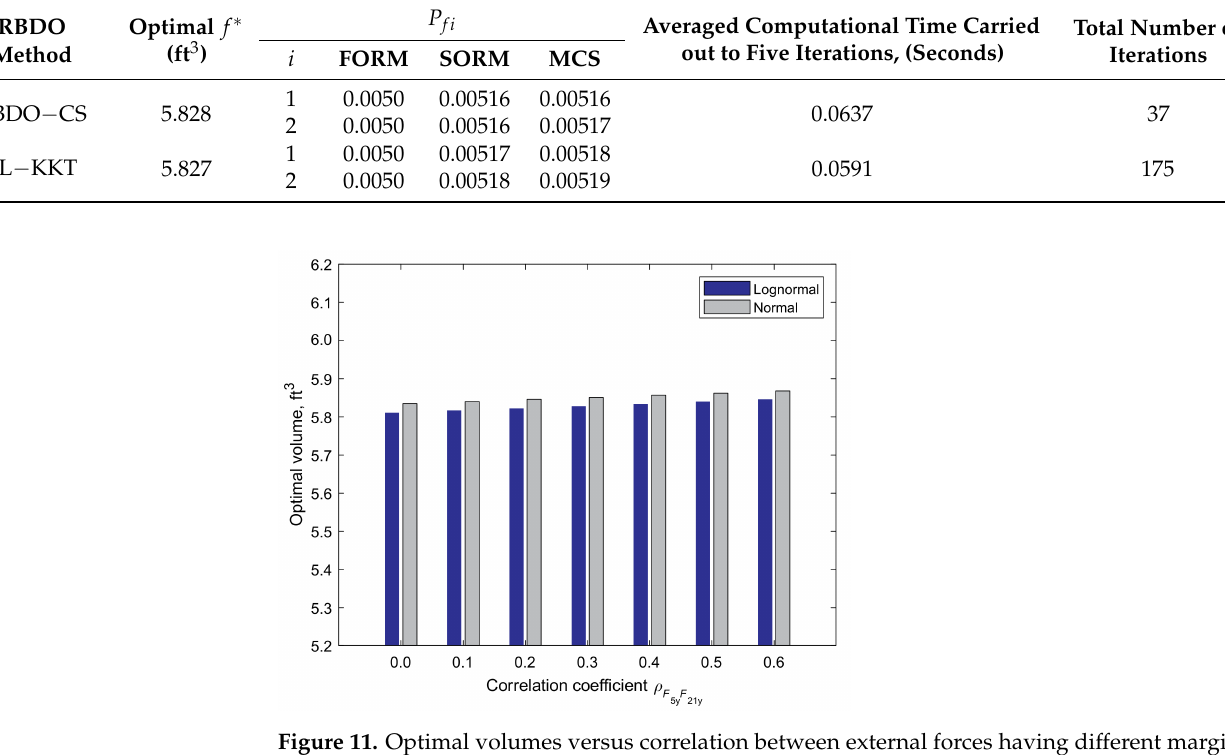
Table 12. Comparison between results from the RBDO − CS and SL − KKT for the truss cantilever structure design.